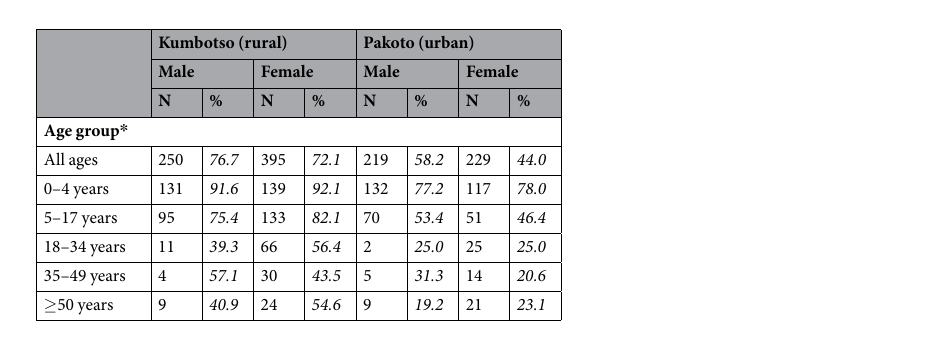
Table 2. Crude carriage prevalence in study locations by age and sex. * Subgroup subtotals may not add up to ‘Ns’ because of missing data (3 females for Kumbotso and 1 each for males and females in Pakoto have missing age